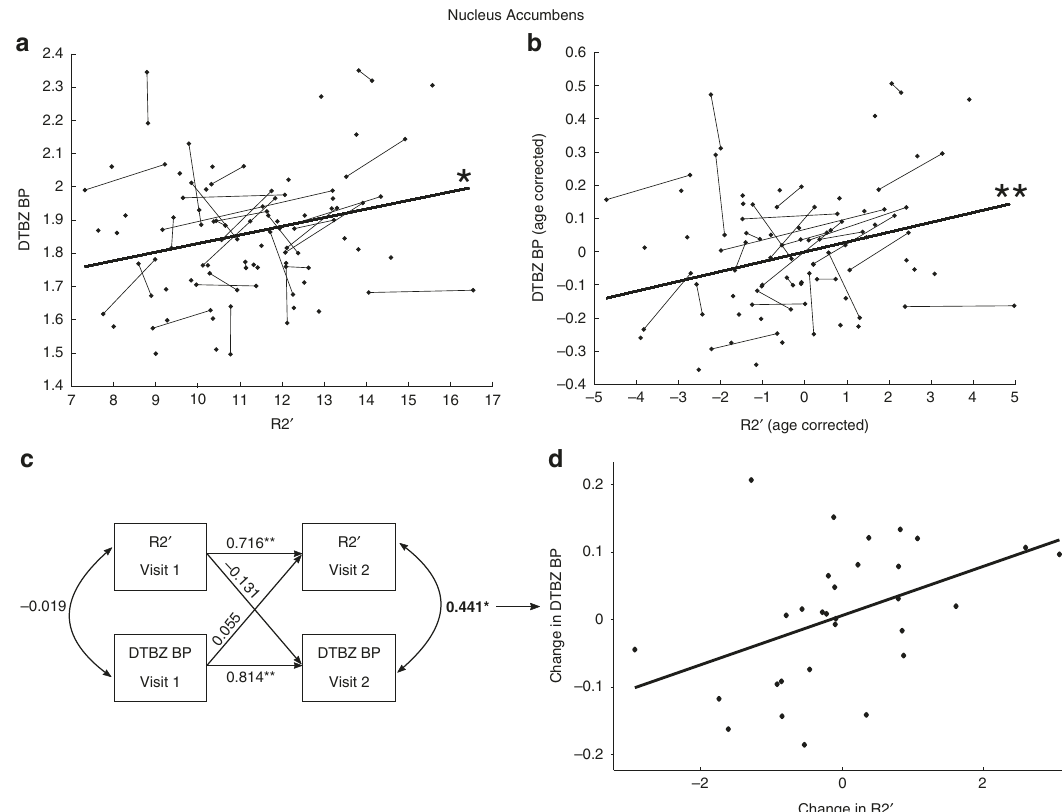
Fig. 2 Association between R2 ′ and [11C]Dihydrotetrabenazine binding potential (DTBZ BP) in the nucleus accumbens. a Tissue iron, assessed with R2 ′ , is signi fi cantly positively associated with VMAT2 ( N = 98 sessions), assessed with [11C]Dihydrotetrabenazine binding potential (DTBZ BP). Results are from a linear mixed-effects model (* p < 0.05 Bonferroni corrected). b This relationship remains after regressing age effects out of both variables (age corrected). c Cross-lagged structural equation model indicating within-subject residualized change in DTBZ BP and R2 ′ at visit two (bolded) are